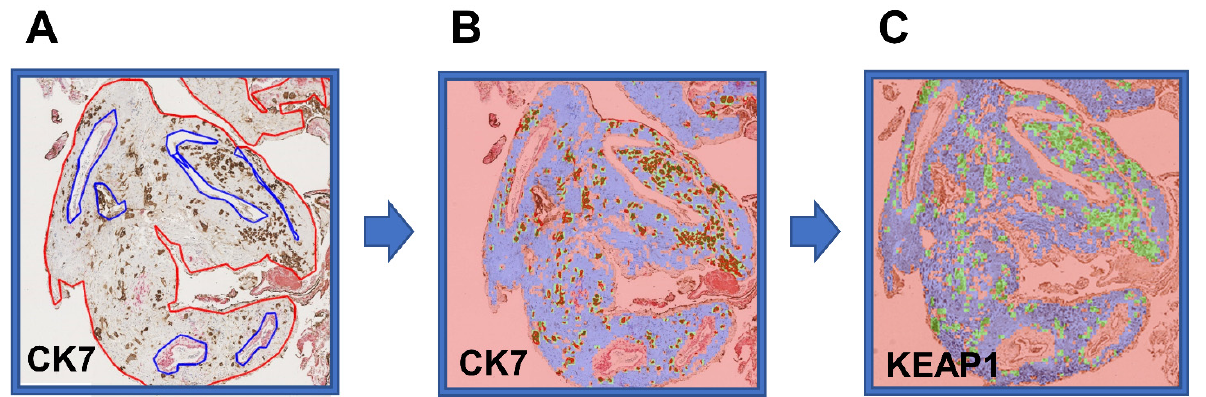
Figure 5. Automated identification of trophoblasts and maternal tissue in decidua for cellular quantification of nuclear factor erythroid 2-related factor 2 (NRF2)- and Kelch-like ECH-associated protein 1 (KEAP1)-protein expression using a custom MATLAB script. Tissue scans of slides stained with the trophoblast marker CK7 were used to determine included (red) and excluded (blue) tissue areas ( A ). Positive CK7 staining identified trophoblast-rich areas (green patches), and lack of CK7 identified maternal-tissue areas (blue patches) ( B ). A mask of patches was created for each decidua based on CK7-positive staining and used to relate NRF2- and KEAP1-expression levels to trophoblasts and maternal tissue in the spatially aligned NRF2 or KEAP1 tissue scans ( C ).